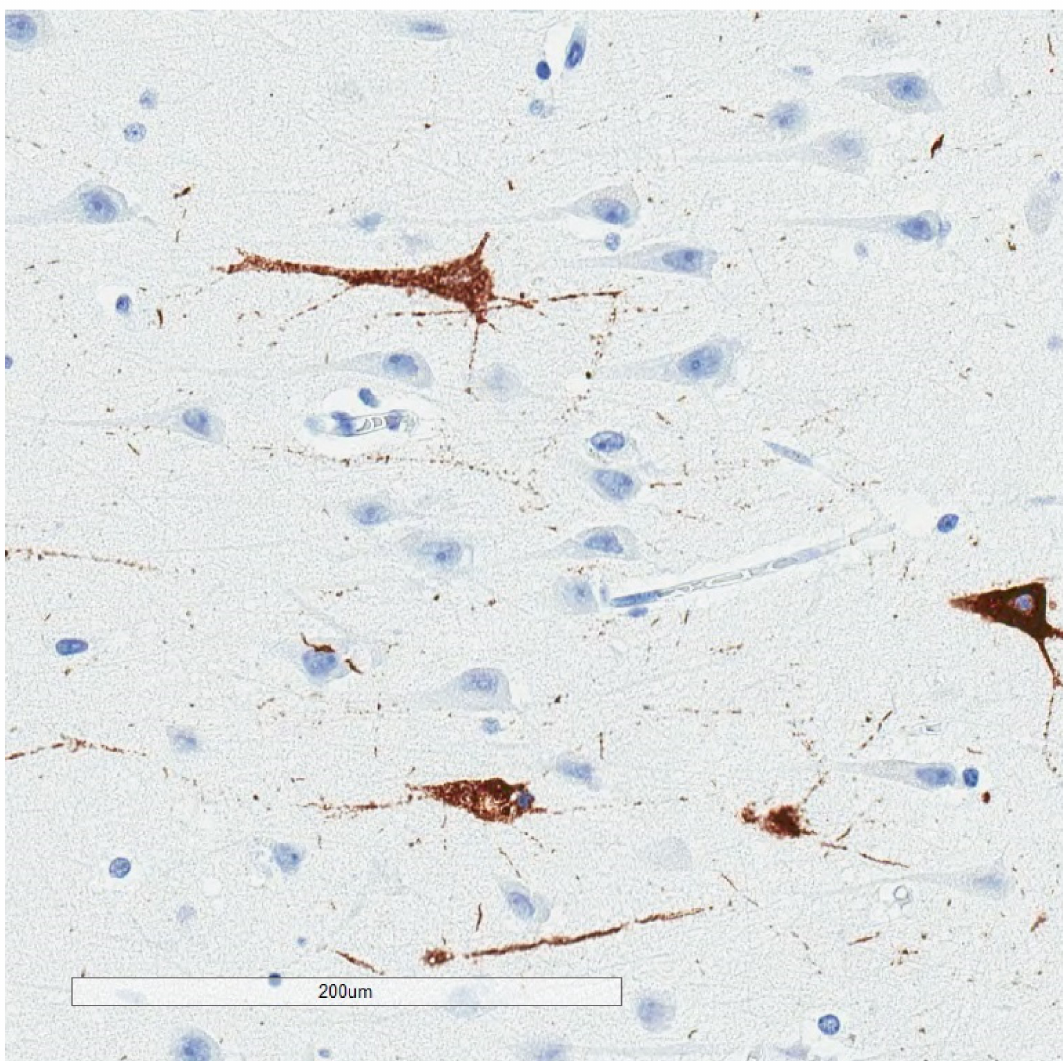
Figure 7. Neuronal pretangles show more di ff use p-tau labeling in the neuronal perikarya. Pretangles tend to lack fibrillarity and